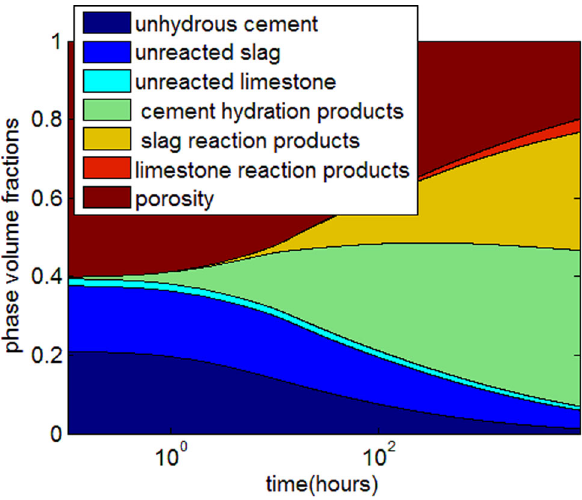
Fig. 6 Phase volume fractions of cement-slag-limestone ternary blends (cement ? 4% limestone ? 40%